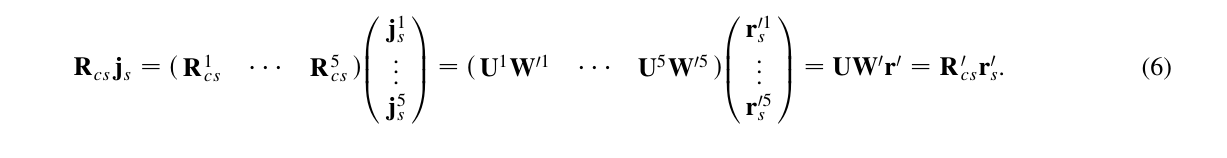
FIG. 1. (Color) Squared singular values of R The rapid decrease indicates that only a few of the columns of R will actually affect the coordinates and the emittance of the cs